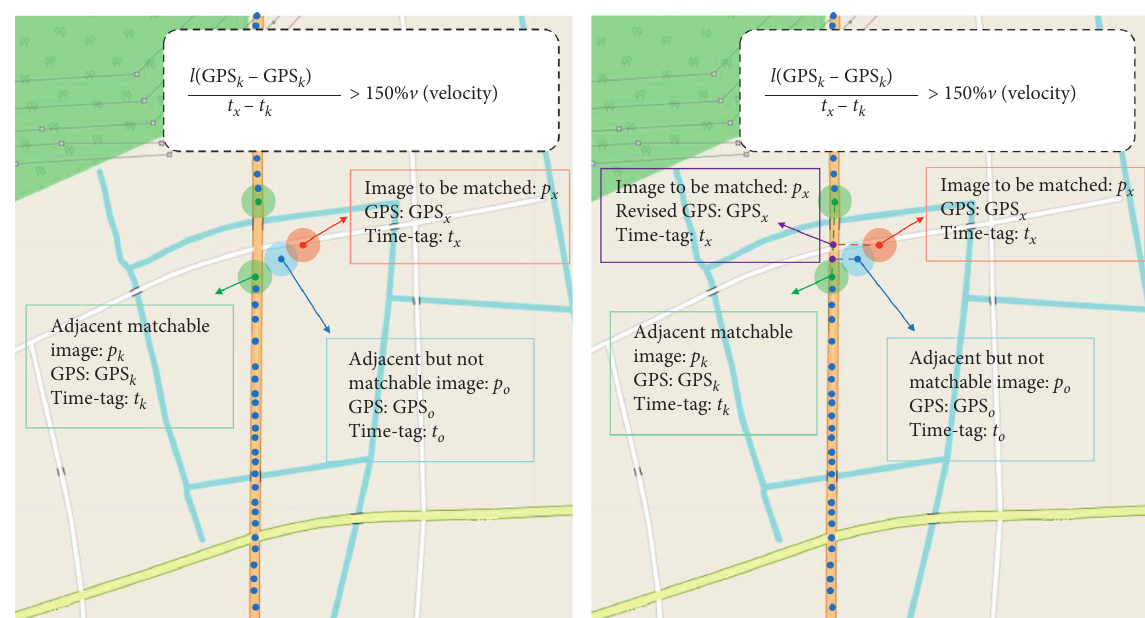
Figure 5: The method of dealing with abnormal data.